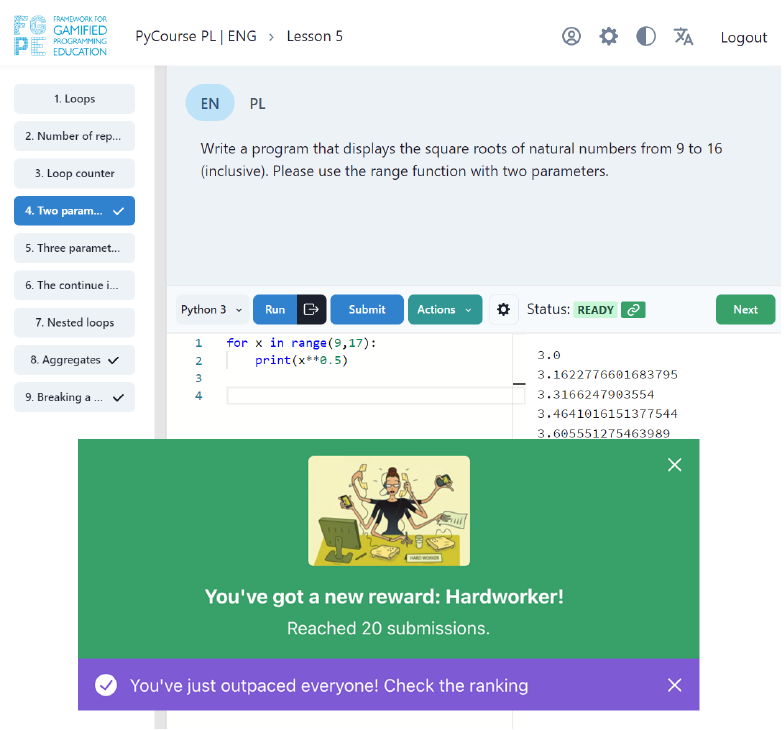
Figure 5. Exemplary screenshot of the FGPE PLE Student